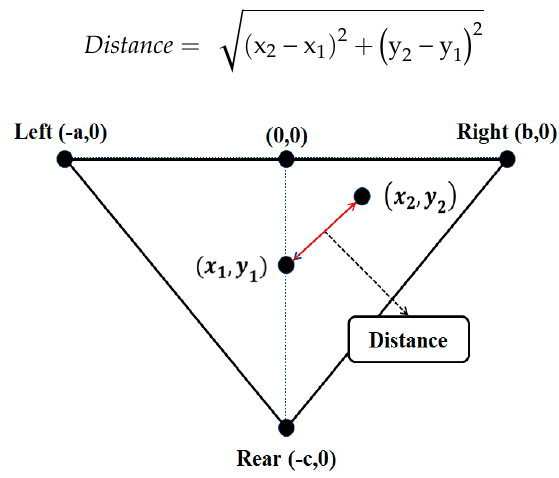
Figure 4. Distance calculation of postural change.